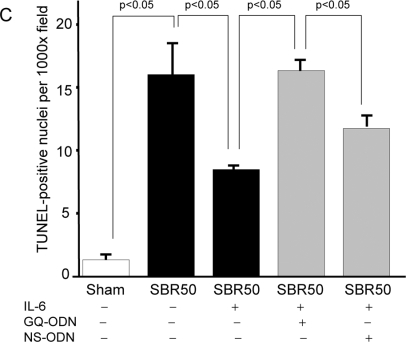
Effect of trauma/HS without or with IL-6 on cardiac apoptosis; impact of Stat3 inhibition on the IL-6 effect.Rats (n≥3 in each group) were randomly assigned to the sham or SBR50 protocol; SBR50 rats were randomized 24 hr prior to trauma/HS not to receive pretreatment or to receive pretreatment with GQ-ODN or non-specific (NS)-ODN by tail vein injection as indicated. At the start of resuscitation, rats in the first two SBR50 groups were randomized in a blinded fashion to receive either placebo or IL-6 at the start of resuscitation; each rat in the last two SBR50 groups received IL-6. In panel A, extracts of cryotome sections of flash-frozen ventricles obtained 60 minutes after the start of resuscitation were used to measure nucleosome levels by ELISA. Data presented are the mean±SEM of nucleosome levels (Units/mg protein); significant differences are indicated (one-way ANOVA followed by Student-Newman-Kuels test). In panel B, sections of fixed ventricles were stained using the TUNEL protocol; representative slides showing TUNEL-positive cells (arrows) are shown. In panel C, the number of TUNEL-positive nuclei was counted in twenty randomly chosen fields of each slide by an experienced microscopist blinded to the treatment the rats received. Data presented are mean number of TUNEL-positive nuclei per field±SEM for each group; significant differences are indicated (one-way ANOVA followed by Student-Newman-Kuels test).